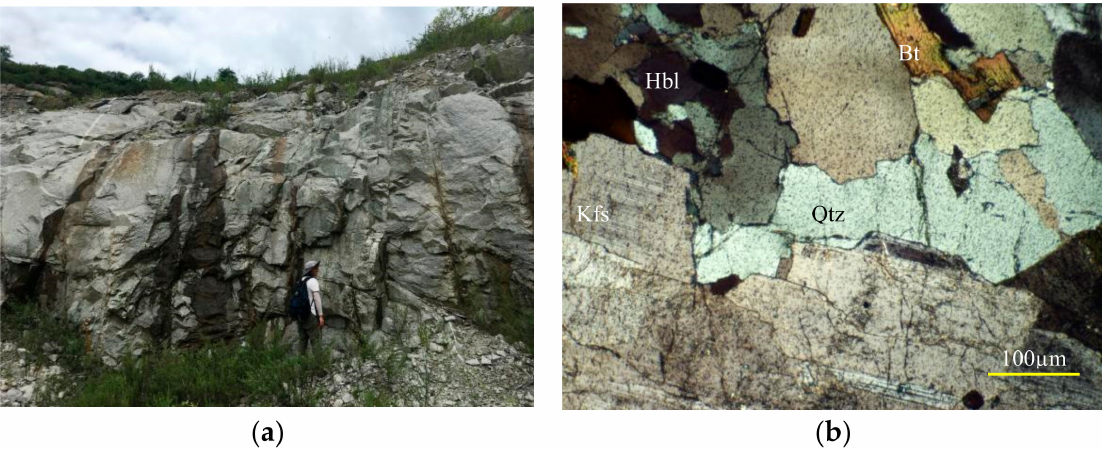
Figure 1. ( a ) Complex fracture system in the Sanguliu granite in the field; ( b ) microcracks observed by the optical microscopy (Kfs: K-feldspar, Qtz: quartz, Hbl: hornblende, Bt: biotite). Table 1. Mineral composition of Triassic granite in the Sanguliu pluton of the Liaodong area. Potassium Feldspar Albite Quartz Biotite Amphibole Clinochlore 39.76% 26.08% 17.7% 9.2% 5.57%